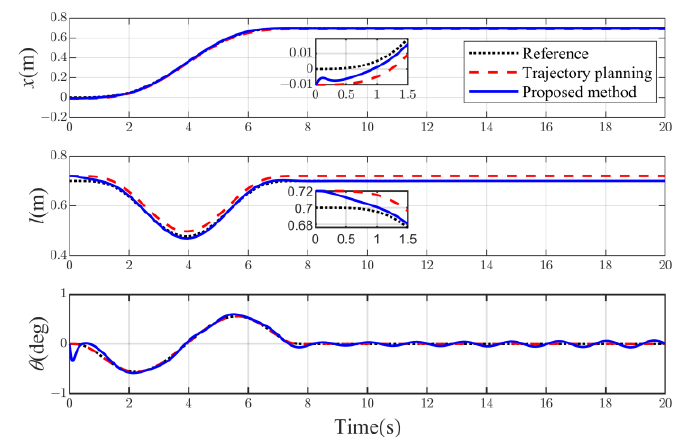
Figure 6. System state with initial deviation.